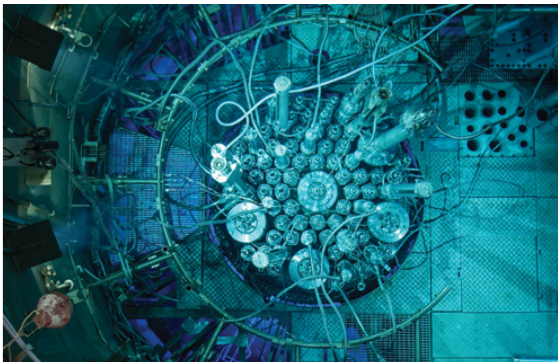
Figure 4. Schematic view of the detector and its passive shielding in Geant4